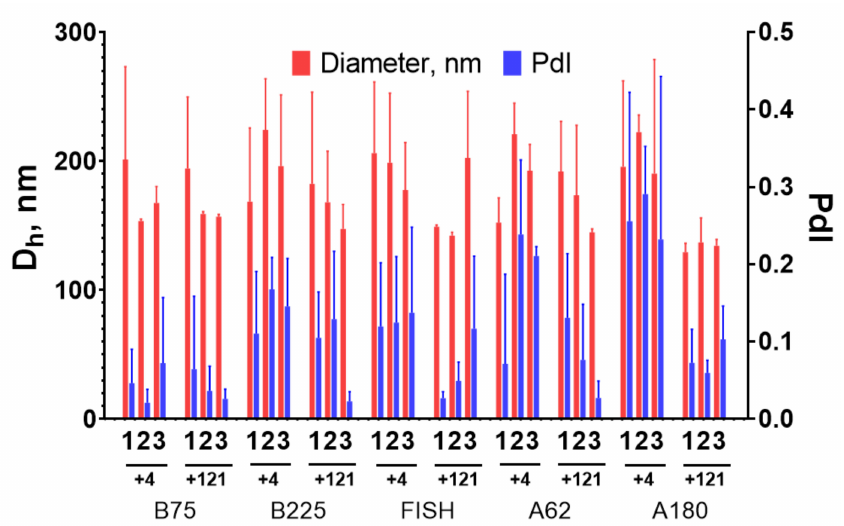
Figure 10. Size (Dh) and polydispersity index (PdI) of non-autoclaved (+4) and autoclaved (+121) gelatin nanoparticles. Mean values of three technical replicates are shown, mean ±